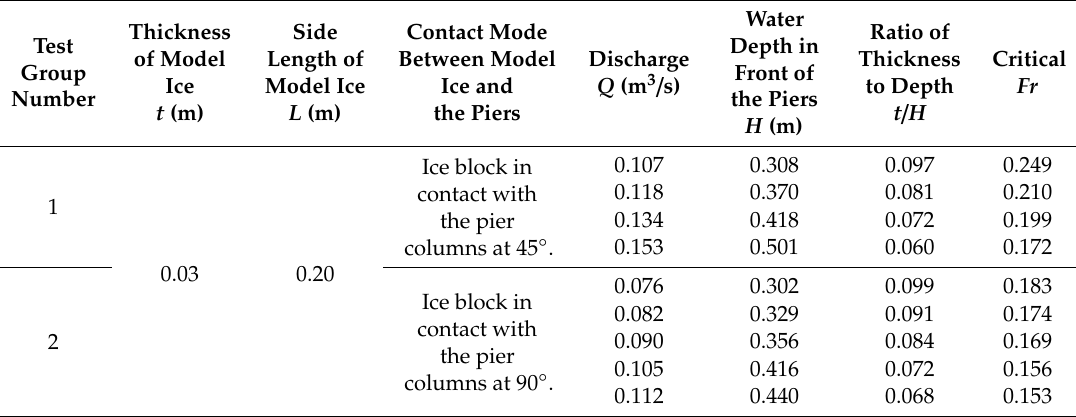
Table A4. At the same side length and thickness of ice, The relationship between critical Fr and t / H at di ff erent contact mode between model ice and the